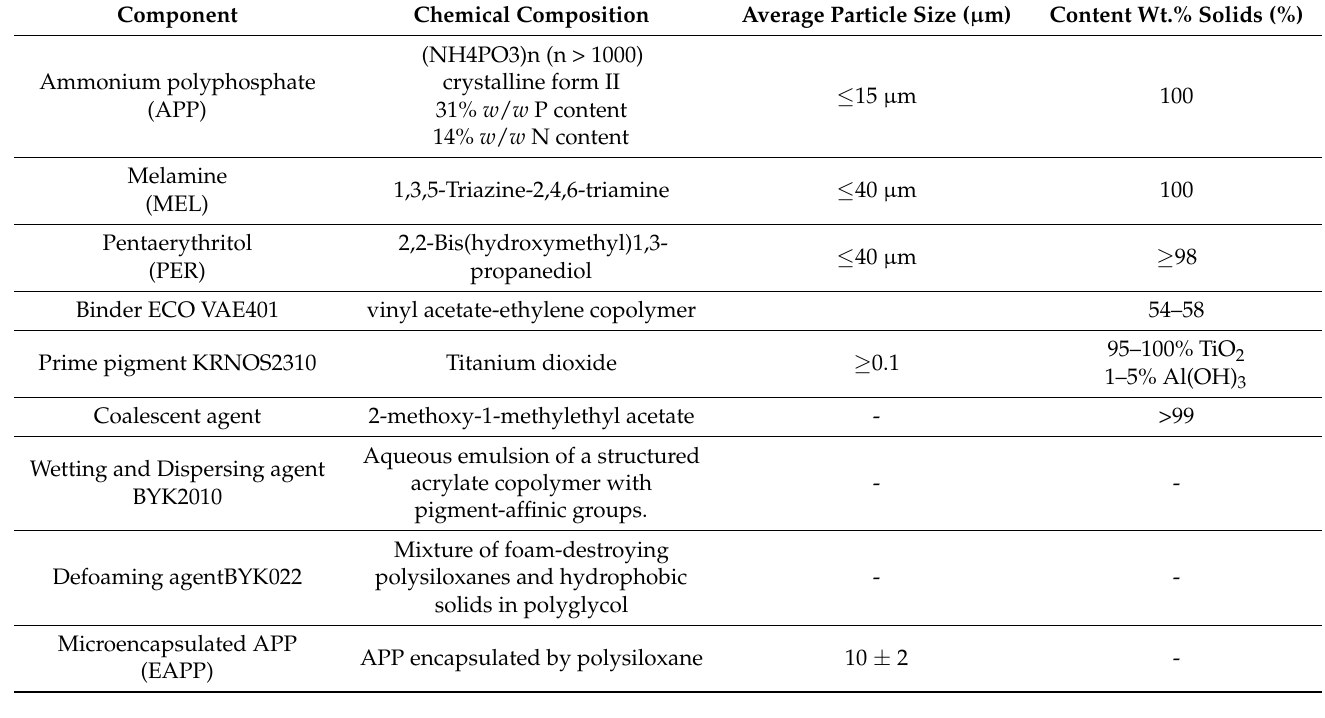
Table 1. Main characteristics of raw materials used in this study to prepare the formulation.